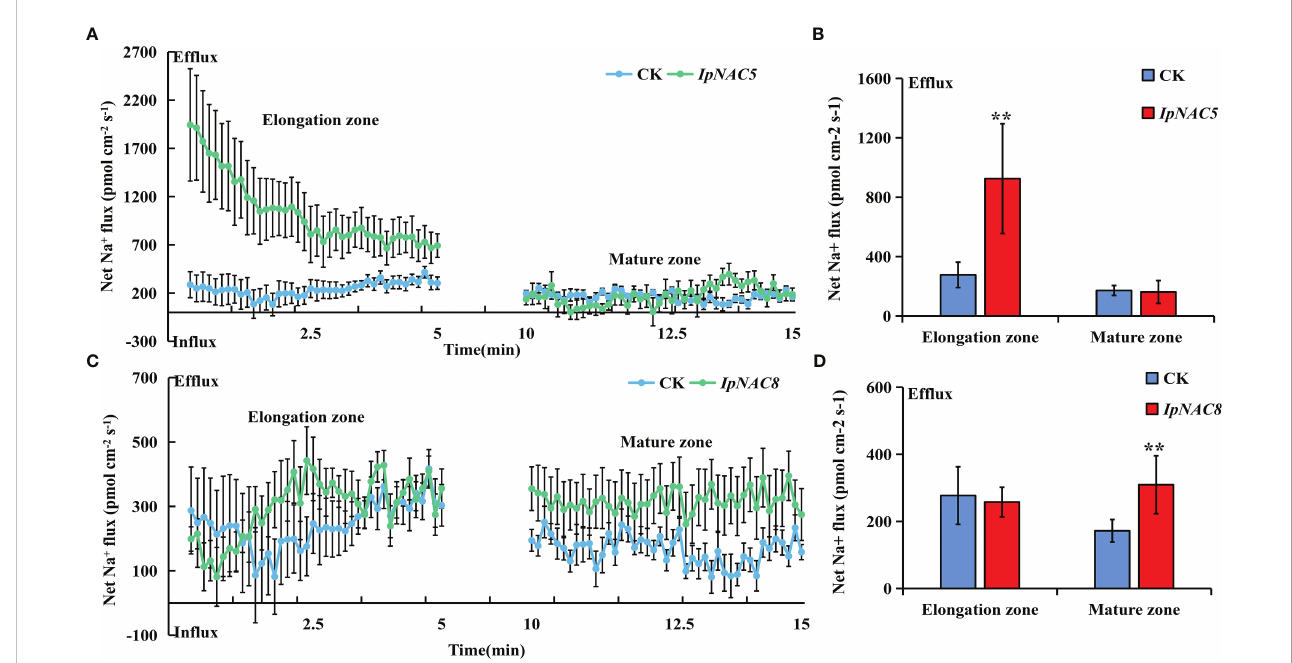
FIGURE 10 Na + fl ux determination in IpNAC5/8 -overexpressing sweetpotato roots. (A, C) The steady-state Na + fl uxes in the AR and TR, including the elongation and mature zones, after 24 h of NaCl treatment (150 mM). The standard errors of the means are represented by the bars. (B, D) Mean net Na + ef fl ux rates in (A, C) , respectively. Asterisks indicate the level of signi fi cance between the AR and TR groups at ** p < 0.01